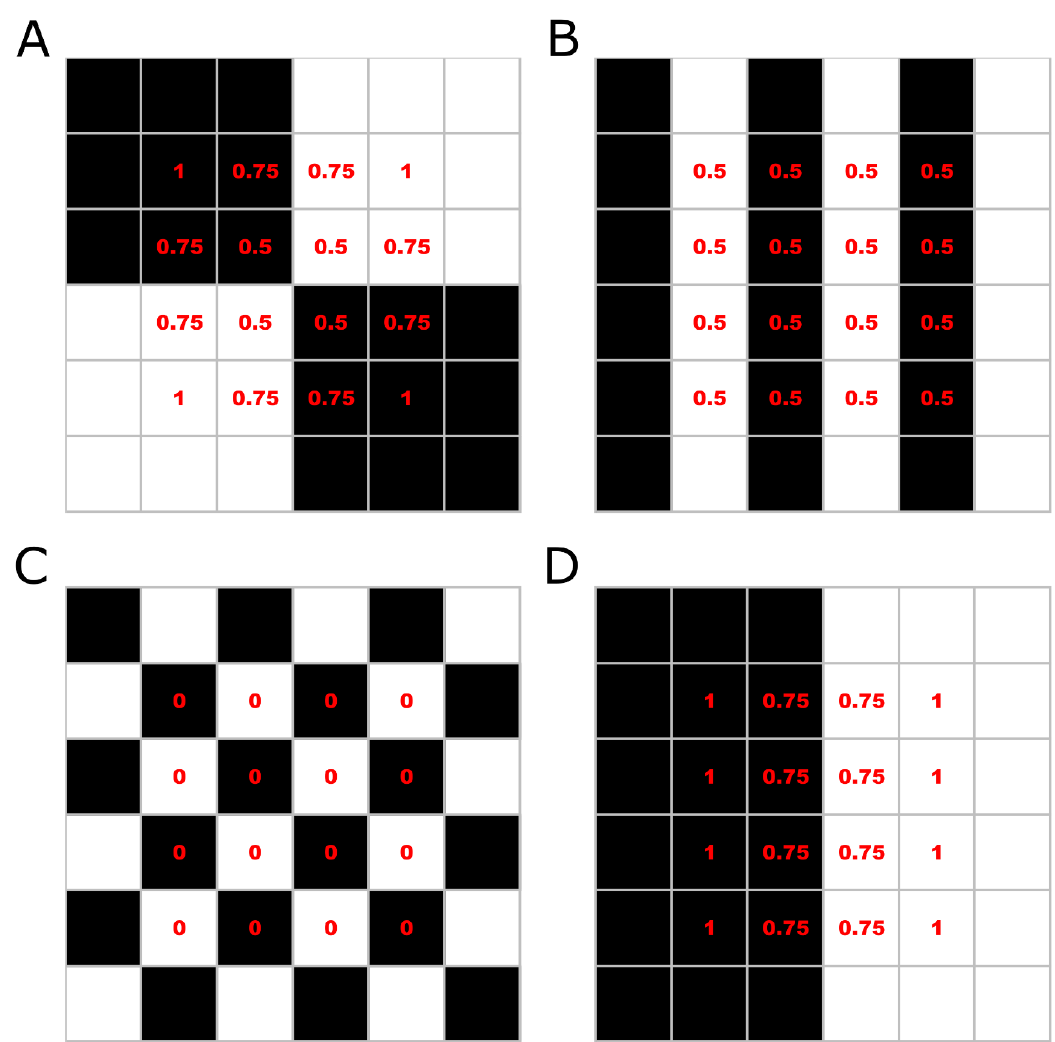
Figure 3. Demonstration of aggregation index calculation. Images represent photos of 6x6 pixel, with 50% black and 50% white pixels. For the aggregation index calculation, first, the proportion of same-color neighboring pixels (SCNP) is calculated (marginal lines and columns are excluded). Then, SCNP are averaged. In these examples, the average SCNP is 0.75 ( A ), 0.5 ( B ), 0 ( C ) and 0.875 ( D ). Next, the maximum and minimum possible aggregation indexes are calculated. In images with 50% black and white pixels, the minimum aggregation will be pixels distributed in chessboard style ( C ), and the highest aggregation will be the aggregation of all same color pixels on each image side ( D ). Thus, by scaling the aggregation by the minimum and maximum possible aggregation, the final aggregation index is: 0.857 ( A ), 0.571 ( B ), 0 ( C ) and 1 ( D